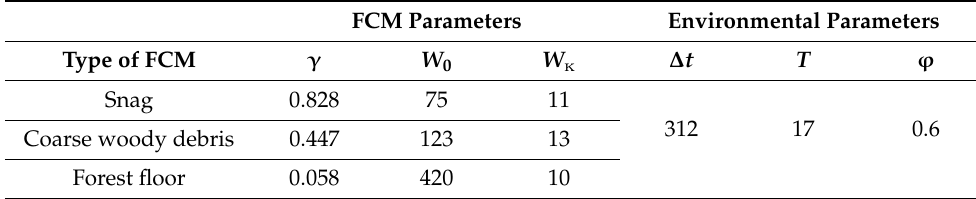
Table 6. FCM and environmental condition parameters.